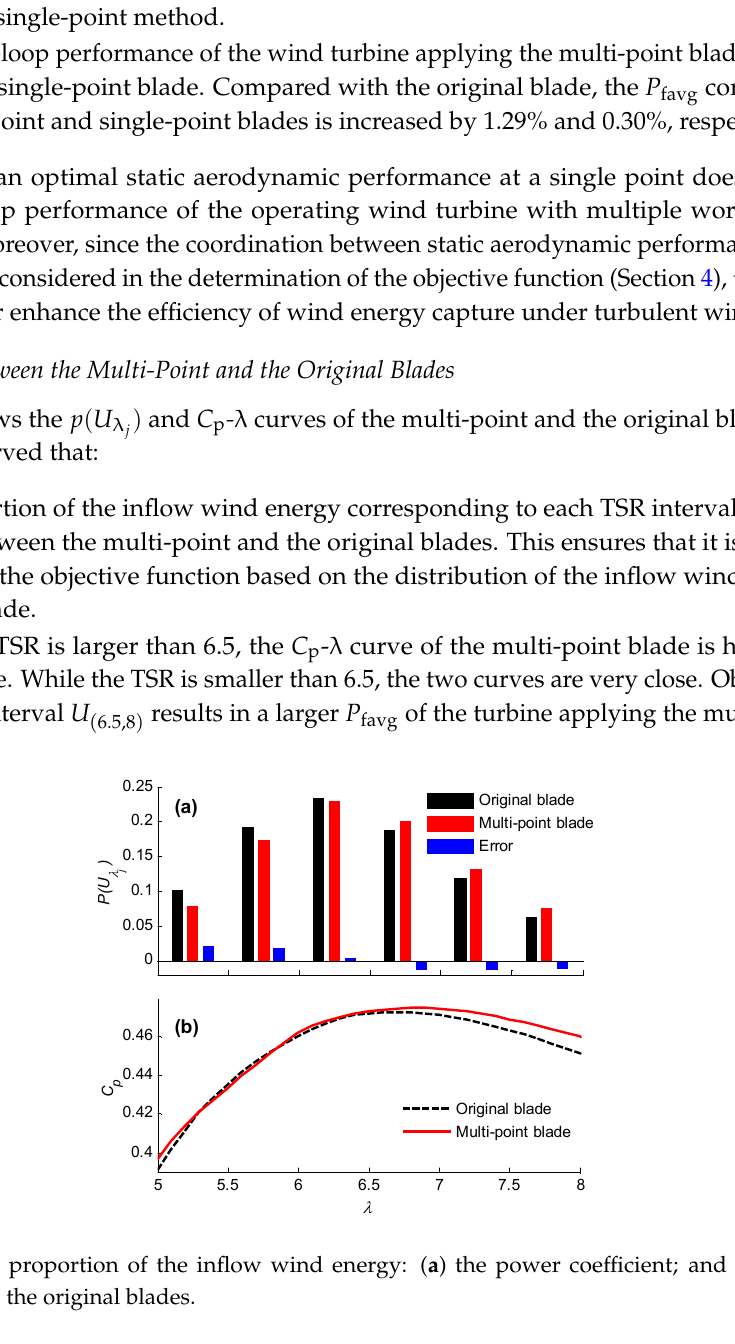
Figure 11. Probability distributions of angles of attack α for the blade elements chosen from the original and multi ‐ point optimized blades. As shown in Figure 11, compared with the original blade element, the probability of small angles of attack α ( − 2°–5°) for the multi ‐ point blade element increases and meanwhile the probability of large α (5°–12°) decreases. This implies that the multi ‐ point blade element spends more time operating at the α range where the lift ‐ drag ratios